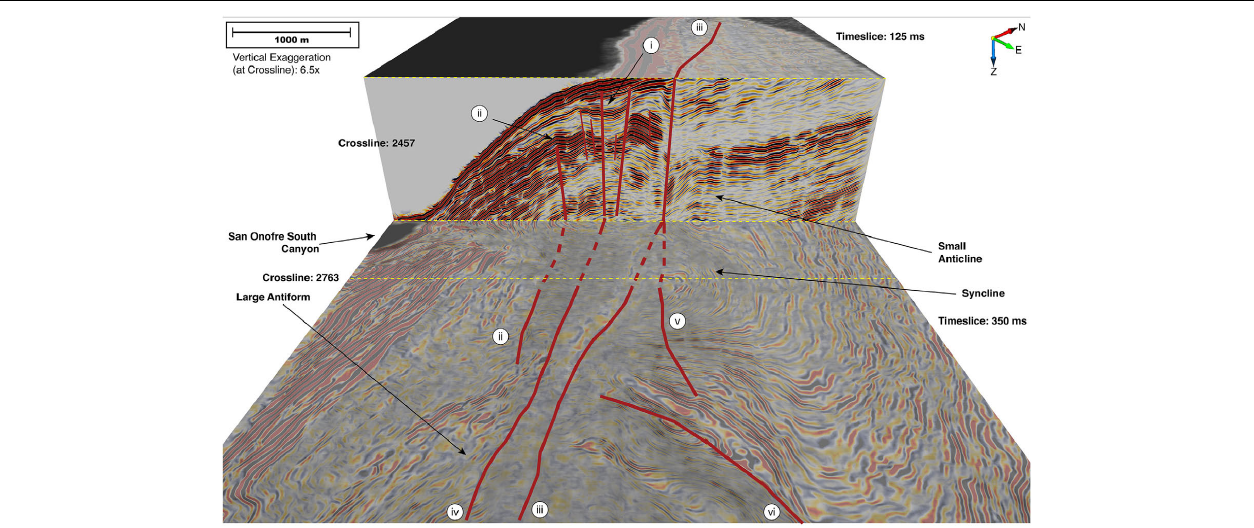
FIGURE 7 | Stair diagram of crossline 2457. Crossline is rendered in amplitudes and shows a seismic cross-section very near San Onofre South Canyon, and north of large antiform structure. Acoustic and deformation character both visibly changes on either side of fault segment iii. Yellow dashed line shows location of crossline 2763.